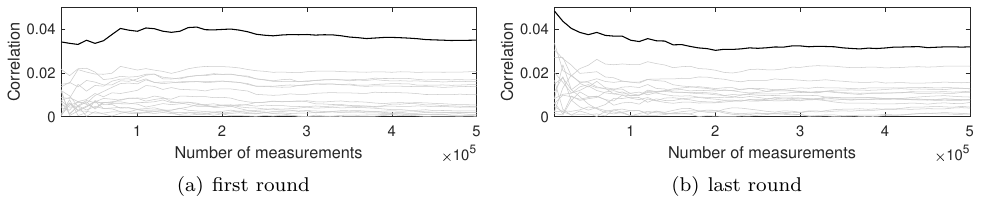
Figure 12: Two CPA attacks on the static power measurements, one on the first round of PRINCE using the LSB of the Sbox output and one on the last round of PRINCE using the LSB of the inverse Sbox input as a leakage